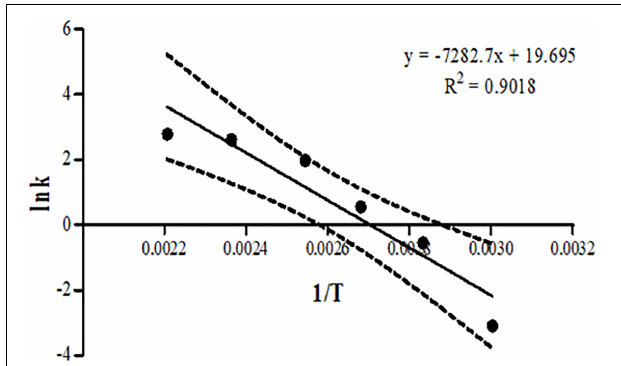
FIGURE 1 | Linear regression of Arrhenius equation in dried red pepper